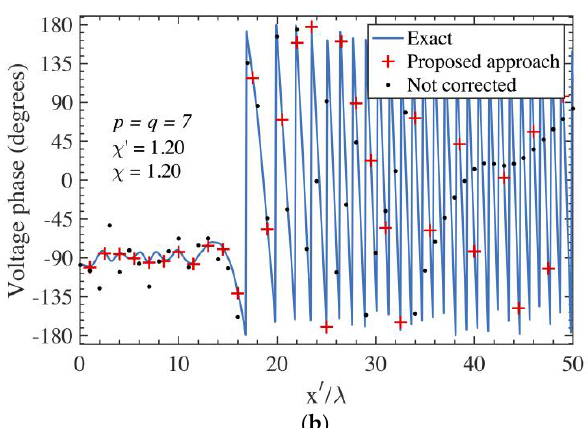
Figure 3. V y on the scanning plane at y ' = 3 λ − AUT 1. Blue line: exact. Red crosses: obtained from the positioning errors corrupted PWMS samples by using the devised multi-steps procedure. Black dots: obtained from the positioning errors corrupted PWMS samples without using the devised procedure. ( a ) Amplitude. ( b ) Phase.